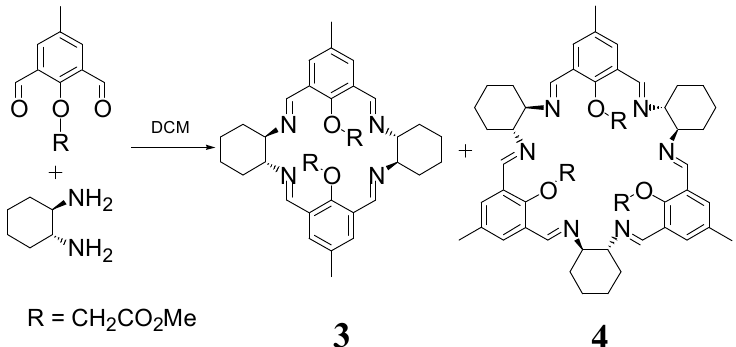
Figure 1. Some of the potential products of the [n + n] condensation of diamines and dialdehydes.